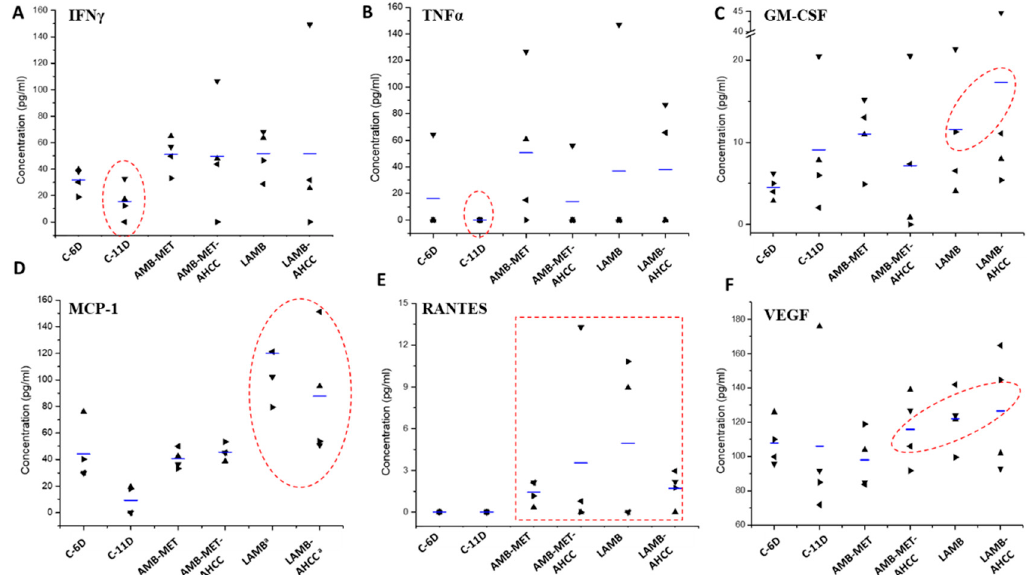
Figure 3. Scattergram of cytokine levels at day 6 and 11 for control group and at day 11 post-infection for all treatment groups. Horizontal lines indicate mean values of ( A ) IFN γ , ( B )TNF α , ( C ) GM-CSF, ( D ) MCP-1, ( E ) RANTES, ( F ) VEGF. Key: C-6D, control group at day six post-infection, C-11D, control group at day 11 post-infection, AMB-MET, and AMB-MET-AHCC, treatment with AMB encapsulated within GCPQ nanoparticles alone or in combination with AHCC ® respectively, LAMB and LAMB-AHCC, treatment with i.v. liposomal AMB alone or in combination with AHCC ® respectively. The most relevant changes in the cytokine patterns have been highlighted within a red circle. a P < 0.05.